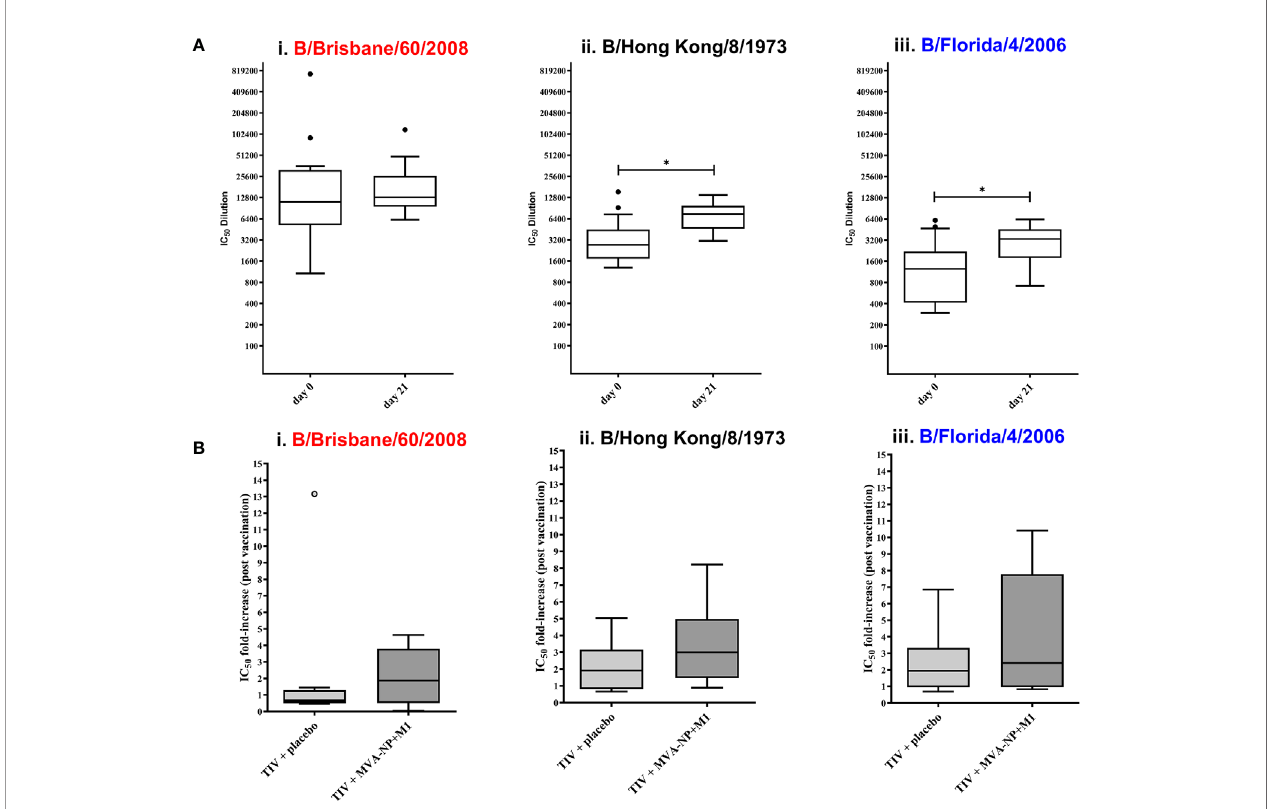
FIGURE 5 | Evaluation of IBV neutralization capacity of NCT0942071 clinical trial sera using in fl uenza B pseudotype microneutralization assay (pMN). The neutralization capacity of human sera from clinical trial (NCT0942071) was assessed pre- and post-vaccination with Trivalent In fl uenza Vaccine (TIV) and then either a placebo saline solution or an MVA-NP fusion protein (n=17). All sera were serially diluted and incubated with each PV: (i) B/Brisbane/60/2008, (ii) B/Hong Kong/8/ 1973, and (iii) B/Florida/4/2006 PV before addition of HEK293T/17 cells. Residual luciferase activity was determined and % neutralization was calculated relative to the PV only control. From this, IC50 values were calculated as the reciprocal of the dilution required to neutralize 50% of initial input PV. Signi fi cant differences between the means of pre- and post-vaccination sera IC50 when tested against PV are indicated in brackets (*p<0.05) (A) . After data strati fi cation on the basis of post-TIV vaccine regimens; TIV + placebo (n=8), TIV+MVA+NP+M1 (n=9), the fold-increase from pre-vaccination IC50 titers were compared to post-vaccination IC 50 (B) . Data is compared using Tukey plots showing the median of the 25 th and 75 th percentile with outliers plotted as those which exceeded 1.5x quartile range. Virus pseudotype from B/Victoria lineage is indicated in red and B/Yamagata lineage in